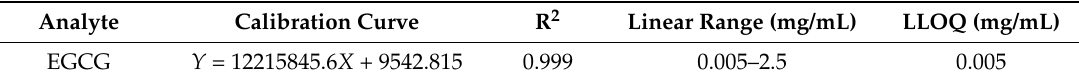
Table 1. Standard curve, correlation coefficient, linear ranges and lower limit of quantification (LLOQ) of EGCG in water.